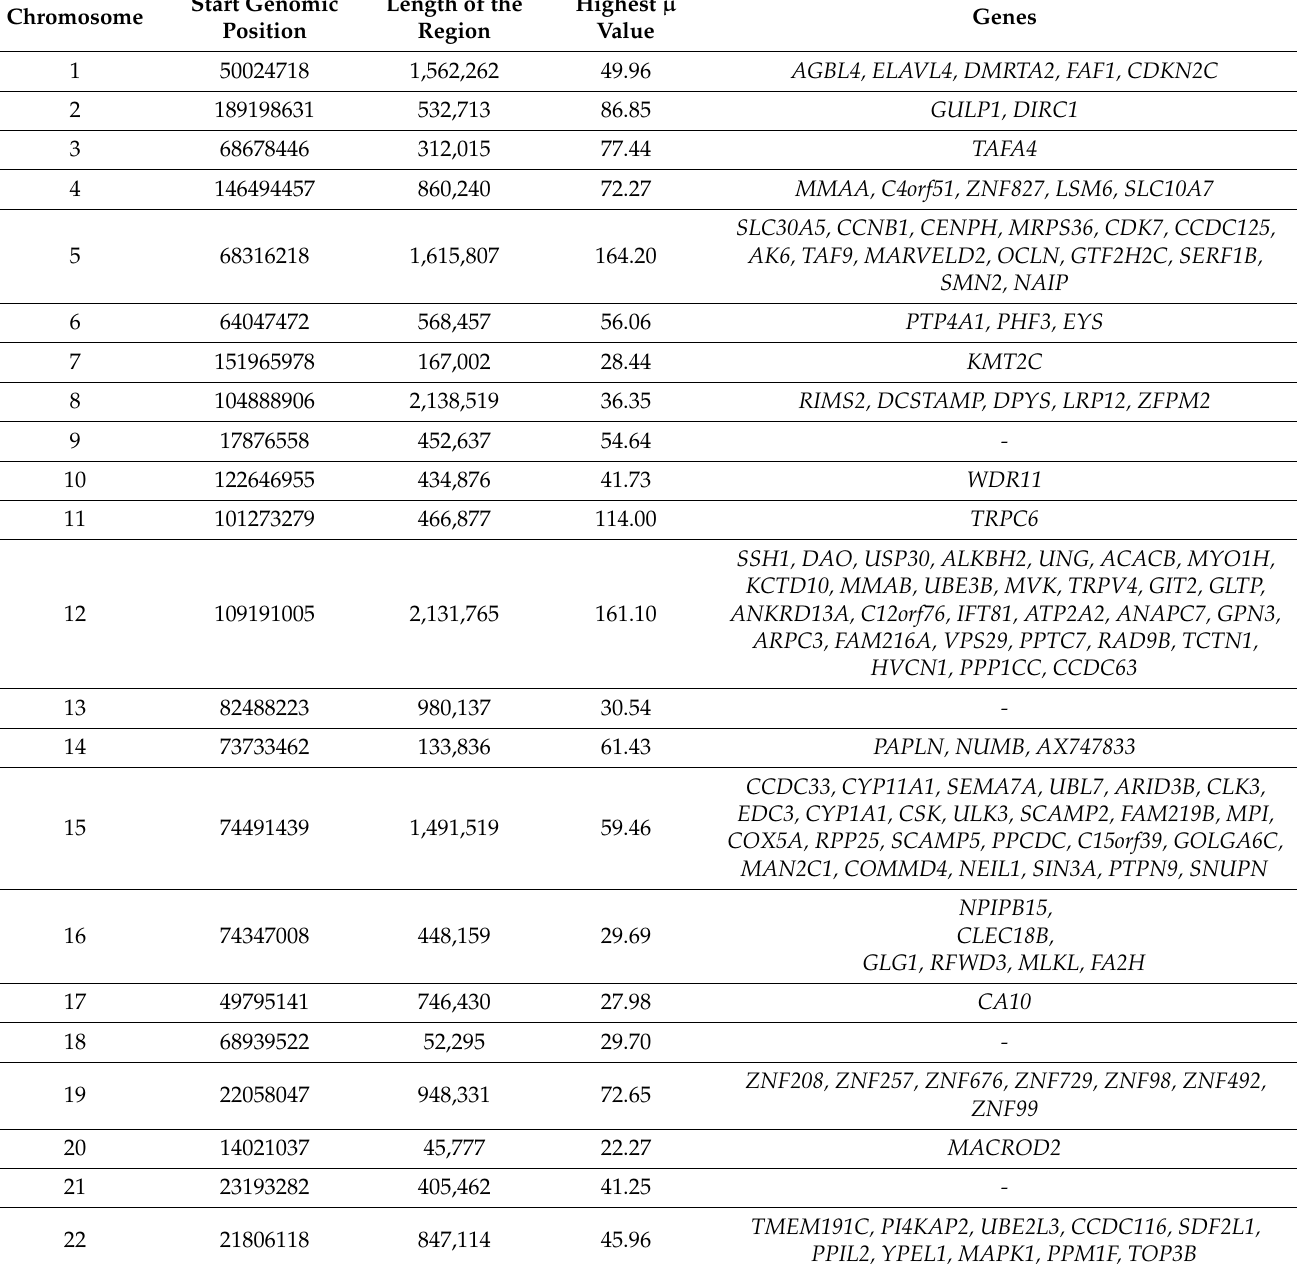
Table 1. Autosomal regions under the positive natural